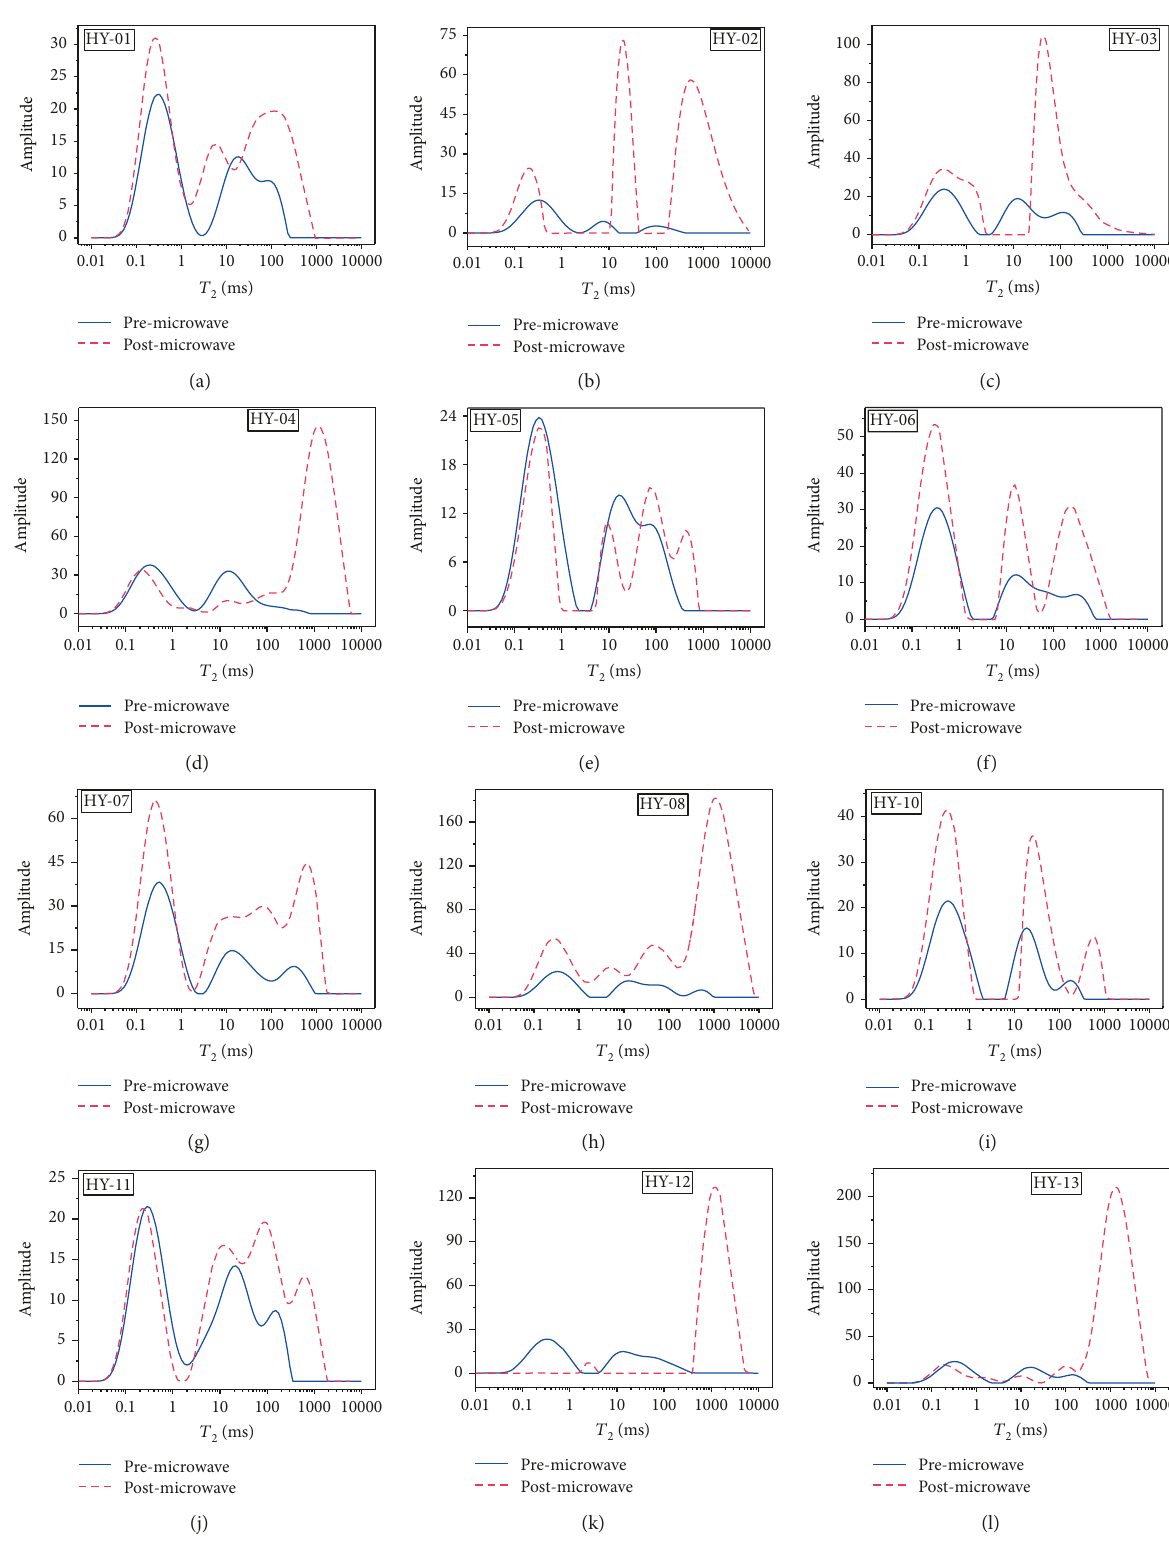
S 2 distribution at w